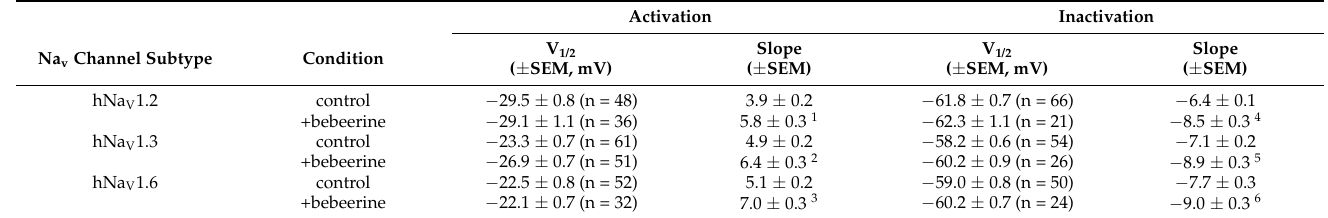
Table 3. Fitting parameters of the voltage-dependent activation and inactivation of Na + cur- rents elicited by the hNa V 1.2, hNa V 1.3, and hNa V 1.6 channels in the absence and in the presence of